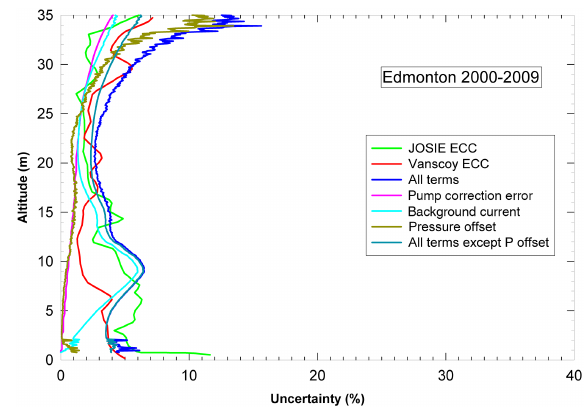
Figure 6. Average estimated uncertainty of ECC (3A and 4A) soundings in the 1980s at Edmonton, showing contributions from selected sources. The total uncertainty without the contribution from radiosonde pressure offsets is also shown, to facilitate com- parison with the JOSIE and Vanscoy intercomparison uncertainty estimates, which were referenced to a common pressure measure- ment. As the overall uncertainty is smaller, the uncertainty in the VIZ radiosonde pressure measurement now dominates the calcu- lated uncertainty above about 26km.